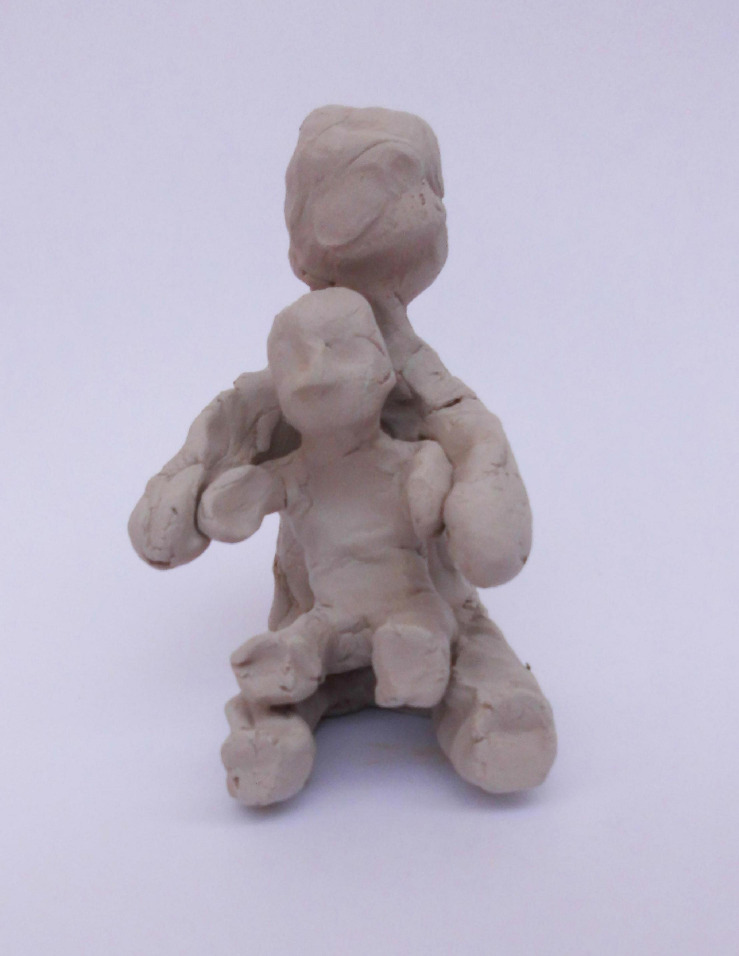
Shalom’s sculpture.